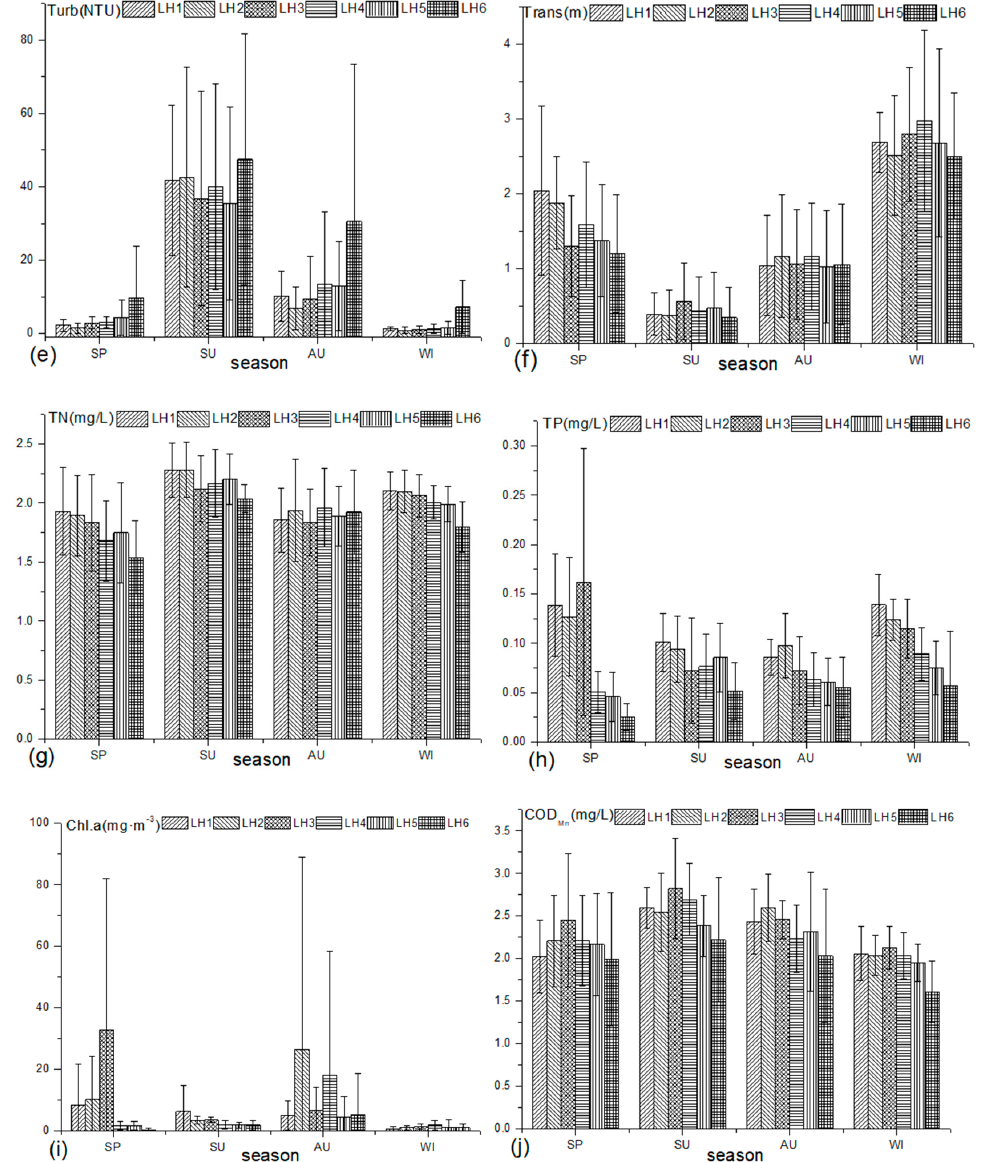
Figure 3. Seasonal variation in 10 water environment variables sampled from six sites from the LRB (LH1, LH2, LH3, LH4, LH5), and LH6: ( a ) WT, ( b ) EC, ( c ) DO, ( d ) TA, ( e ) TURB, ( f ) TRANS, ( g ) TN, ( h ) TP, ( i ) Chl.a, and ( j ) COD; SP: spring, SU: summer, AU: autumn, WI: winter.